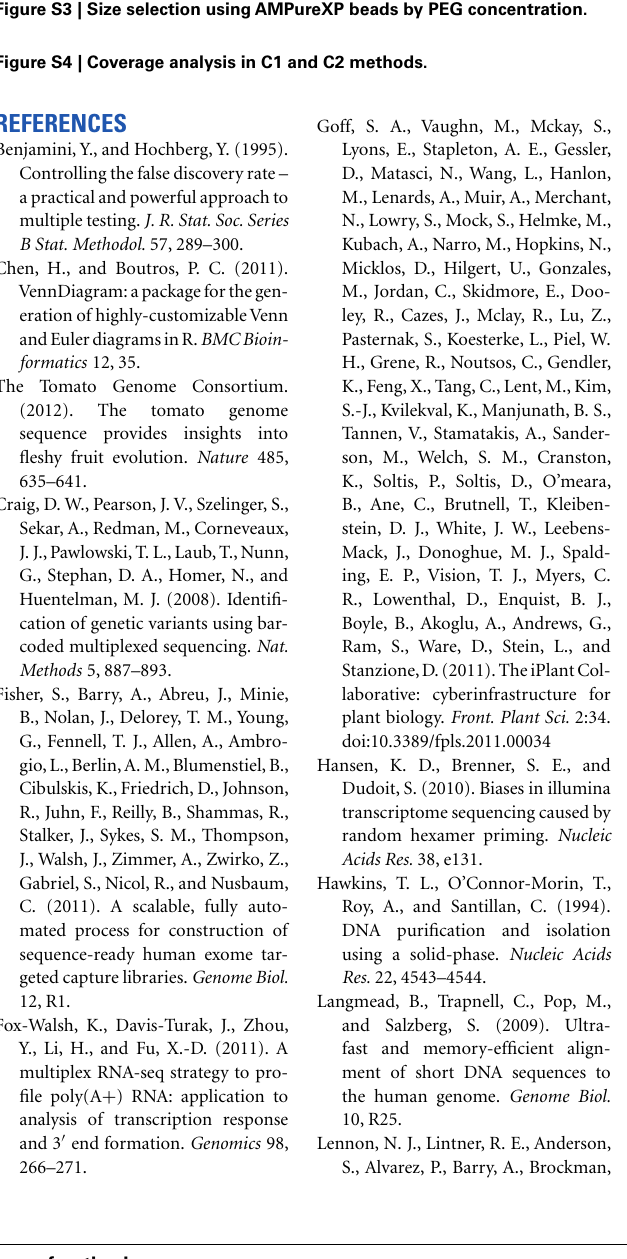
Table S1 | Multiplexing information and read statistics of the samples.